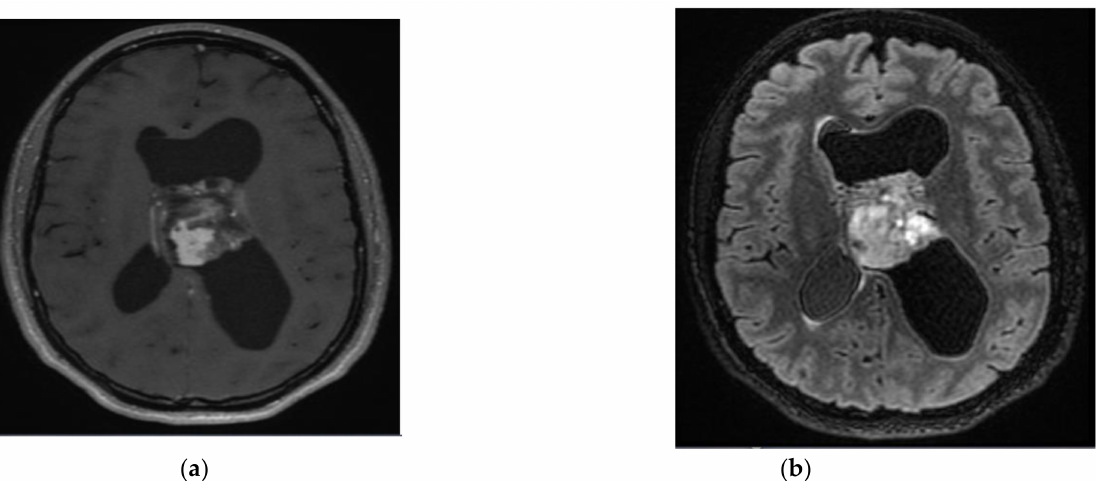
Figure 1. A 29-year-old female’s central neurocytoma. After surgical resection, the patient was moni- tored without recurrence. ( a ) T1-weighted image after gadolinium infusion; ( b ) Flair-weighted